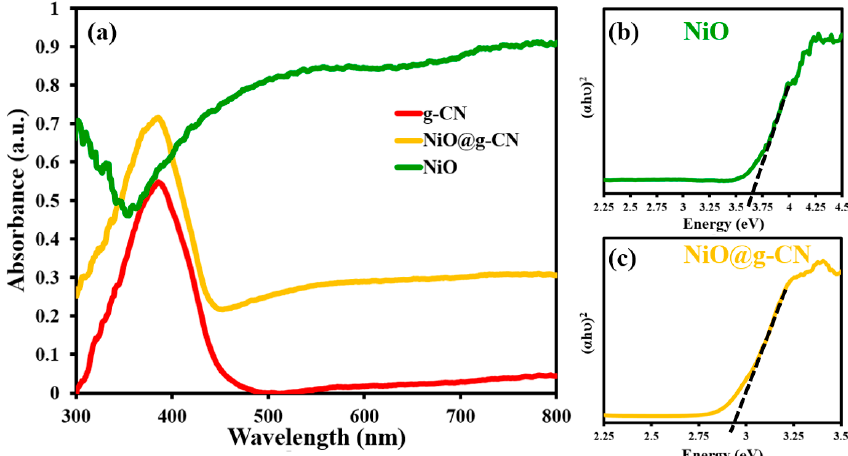
Figure 6. UV-DRS spectra of pure g-CN, pure NiO, and the NiO@g-CN nanocomposite ( a ). Tauc plots of NiO ( b ) and the NiO@g-CN nanocomposite ( c ).